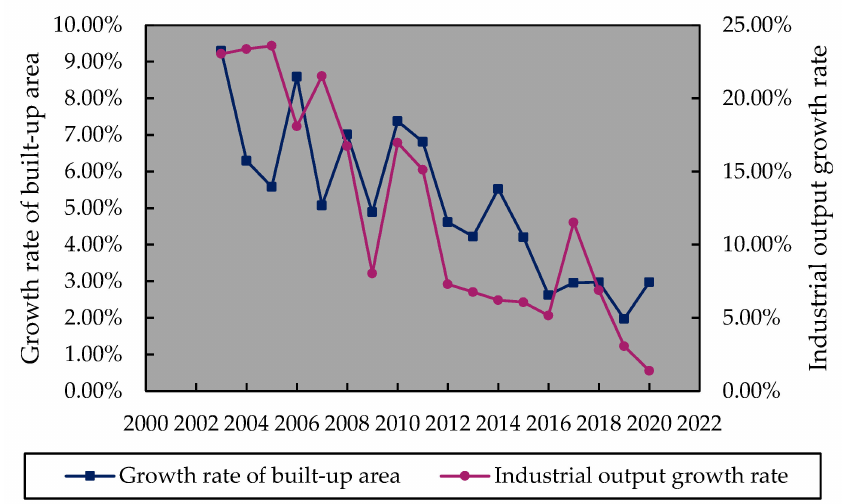
Figure 7. Trends in the expansion of built-up areas and industrial development in Jiangsu from 2002 to 2020.